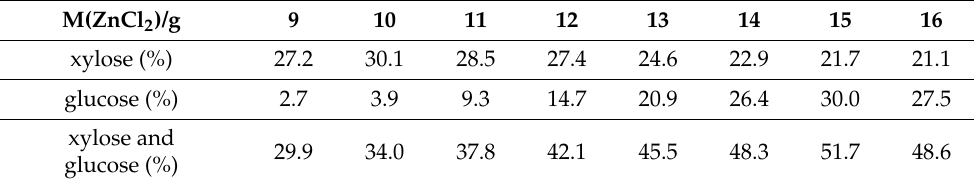
Table 1. Effect of ZnCl 2 content on xylose and glucose yield (one pot).